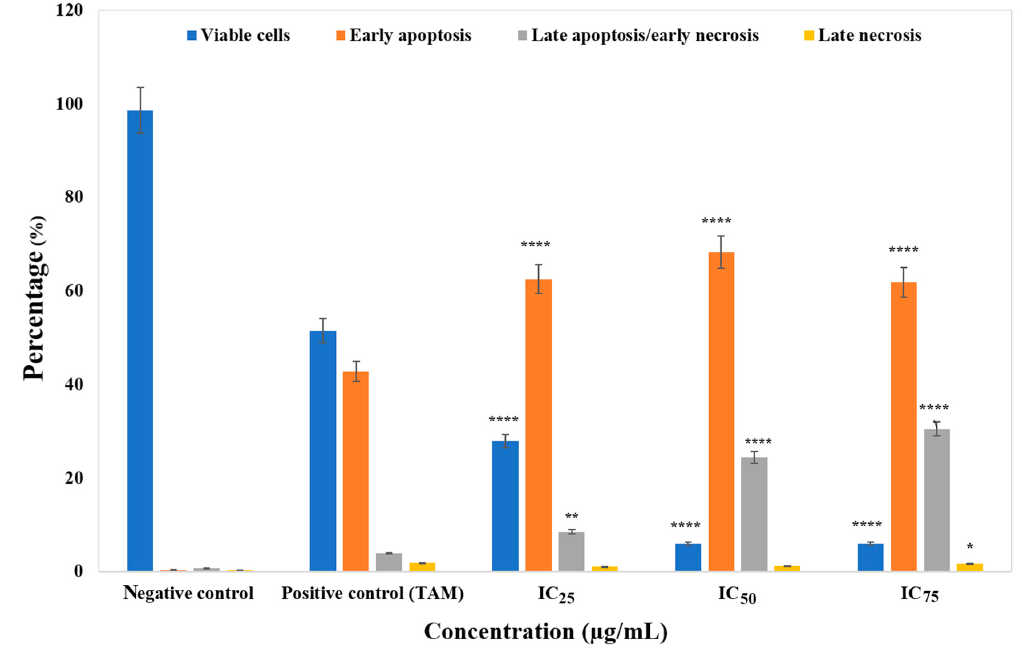
Figure 3. The percentage of viable, early apoptotic, late apoptotic/early necrotic, and late necrotic cells with respect to negative control (untreated), positive control (tamoxifen), and MCF-7 cells treated for 24 h as determined by a flow cytometer instrument. Cells were exposed to different concentrations of ZnO NPs for 24 h. Data represent the mean ± SD ( n = 3). More information on cell percentages is provided in Appendix B. * p ≤ 0.0.5; ** p ≤ 0.0; *** p ≤ 0.001; **** p ≤ 0.0001.